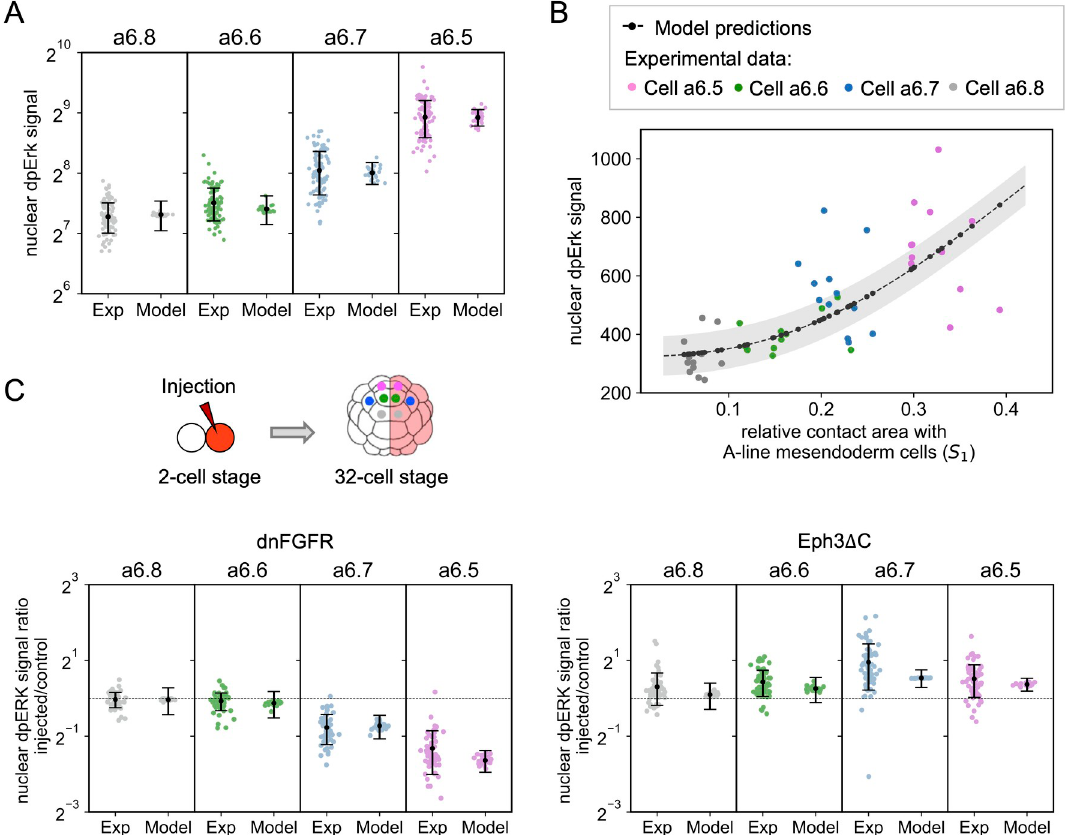
Fig 2. Control of ERK activation by cell contact surfaces. (A) Nuclear dpERK immunofluorescence (IF) signals in the a6.5, a6.6, a6.7 and a6.8 cell types as measured in IF experiments (left) and computed with the model (right, Erk f values). Each point represents a single cell and modeling results are computed using the measured values of S 1 . Means and standard deviations are shown in black. A = 1850 and B = 155.11 in Eq (14). (B) Nuclear dpERK IF signals in individual a-line cells are shown as a function of the relative area of cell surface contact with A-line cells in experiments and in the model. Experimental data are shown in grey (a6.8 cell type), green (a6.6 cell type), blue (a6.7 cell type), magenta (a6.5 cell type), predictions of the model in black. Hill coefficient obtained by fitting the model predictions with a Hill function: 2.41. A = 3000 and B = 324.52 in Eq (14). The area shaded in grey represents the uncertainty on the model prediction. (C) Injected/control ratios of nuclear dpERK signal in dnFGFR half-injected embryos (on the left) and in Eph3 Δ C half-injected embryos (on the right). Left and right columns show experimental dpERK IF and computed Erk f ratios, respectively. Injection of dnFGFR and Eph3 Δ C were modeled by considering R T = 100 and Q T = 10, respectively. A = 1850 and B = 155.11 in Eq